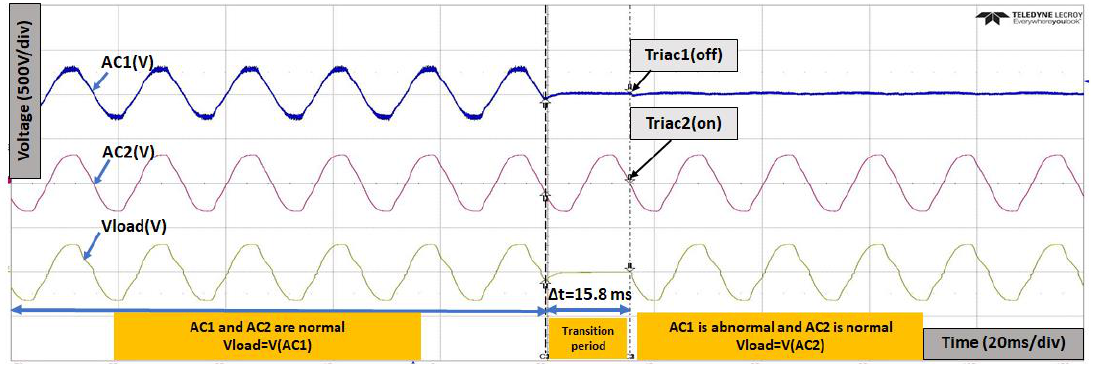
Figure 13. Experimental voltage waveforms and transition time calculations when the AC1 source is faulted during the voltage waveform fall time.